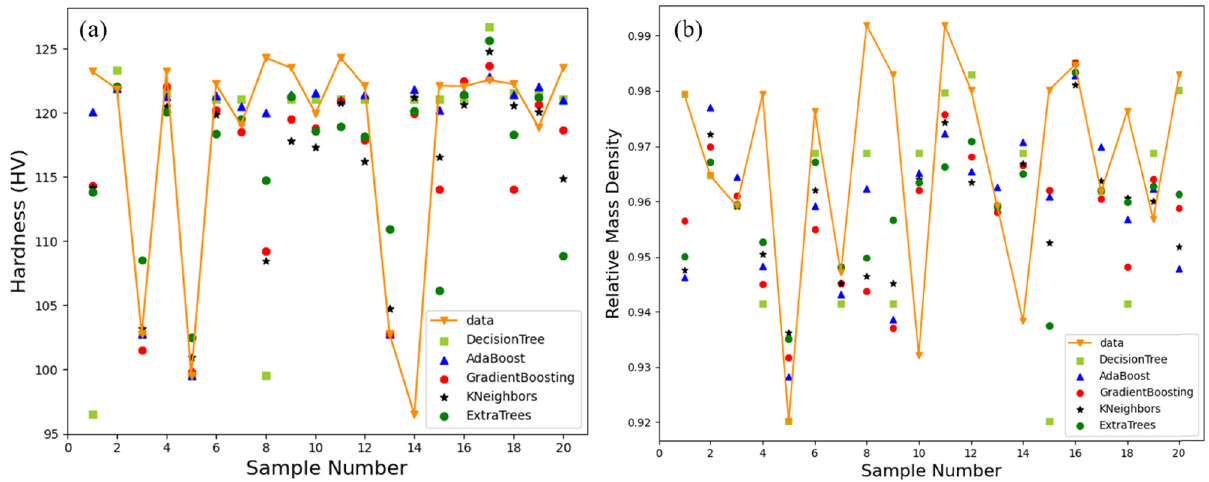
Figure 11: ( a ) Surface hardness and ( b ) relative mass density prediction of CNTs/AlSi10Mg nanocomposites using di ff erent ML methods with subgrain cellular structure features as input.